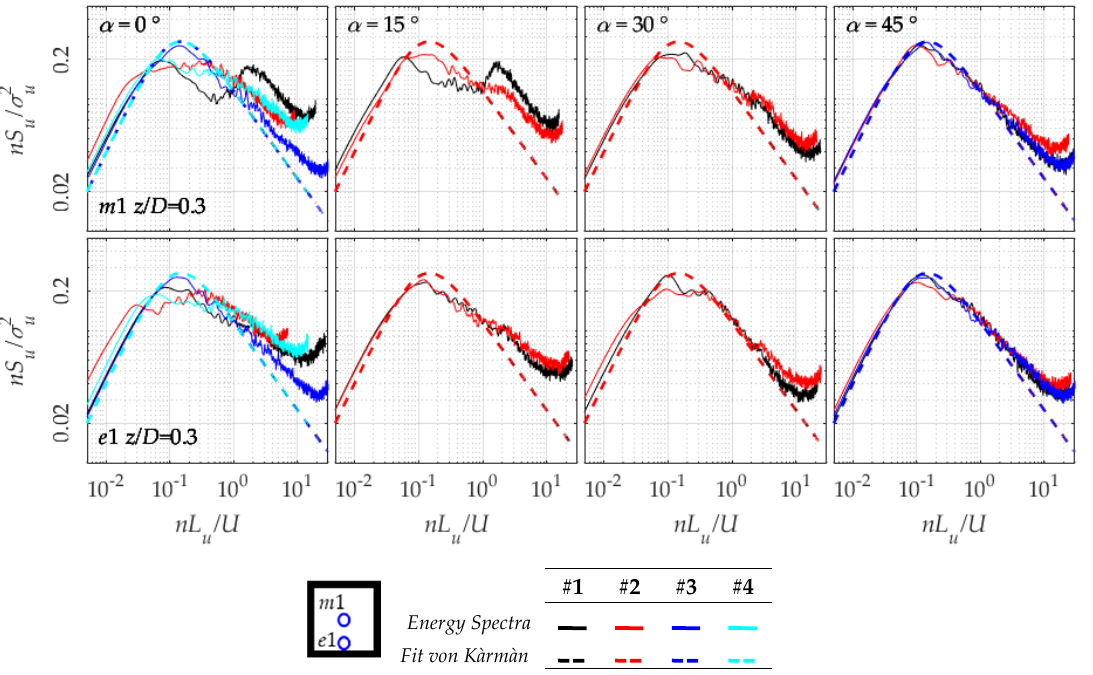
Figure 15. Power Spectral Density of wind speed at position e 1 (bottom row) and m 1 (top row) for the four wind directions (columns) and configurations. The dashed line indicates the von Karman fit for the various configurations, as calculated using Equation (1).